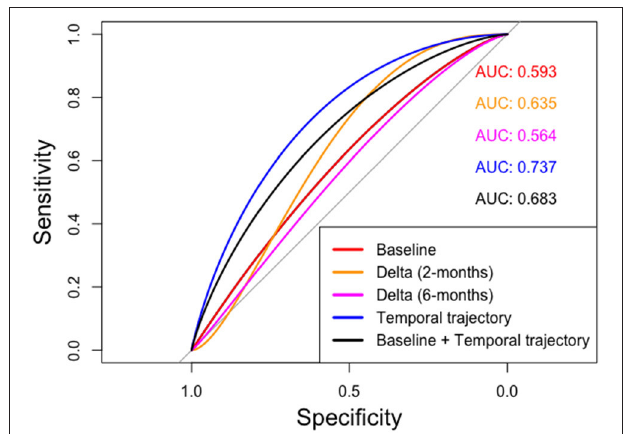
FIGURE 5 | ROC curves computed for various radiomics feature based approaches. The temporal trajectory model using MFPCA (blue) performs better than the other four models: (i) baseline model (red), (ii) delta model after 2-month follow-up (orange), (iii) delta model after 6-month follow-up (purple), and (iv) an ensemble of baseline and temporal trajectory models